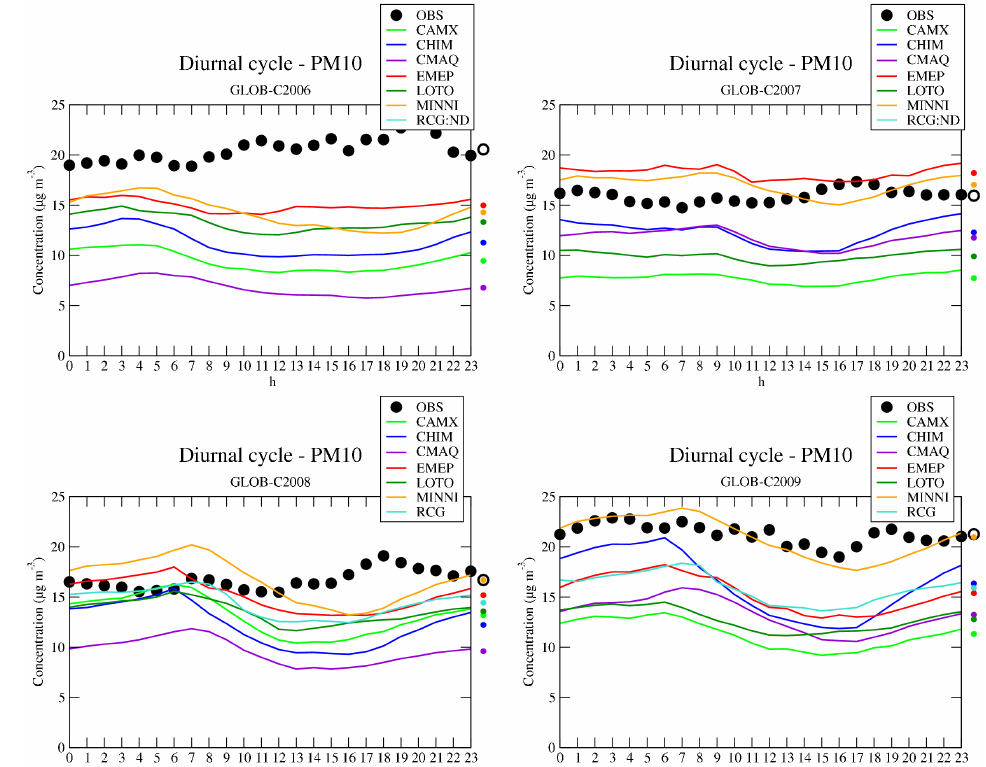
Figure 13. Mean diurnal cycles of PM 10 for all campaigns simulated by the models compared with observations. Averaged concentrations are provided on the right side of the